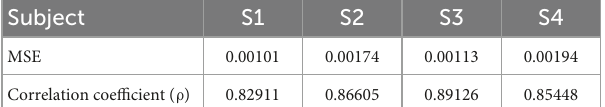
TABLE 2 Evaluation